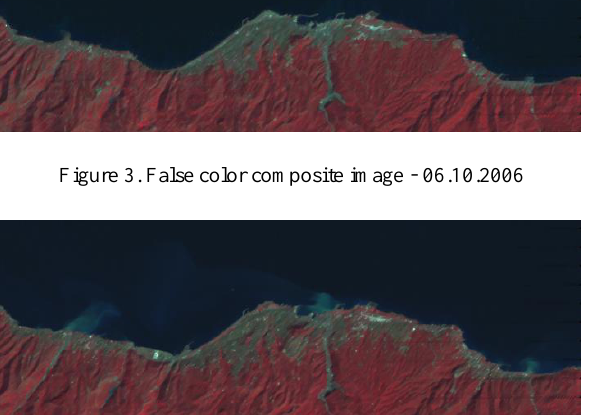
Figure 4. False color composite image - 01.10.2016